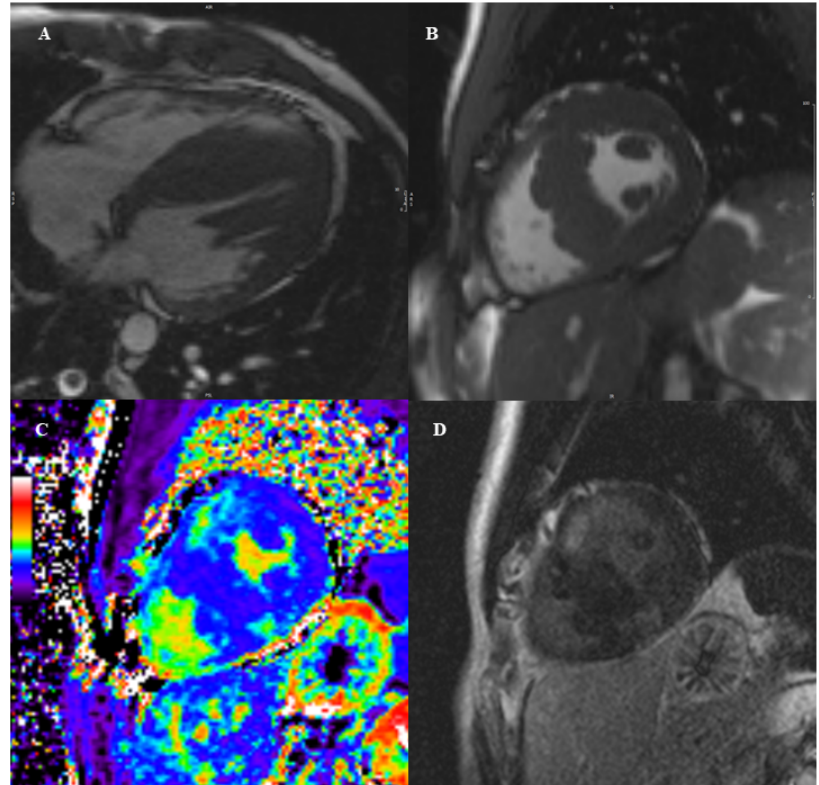
Figure 2. 13 year-old boy with positive family history for HCM. The CMR examination showed an asymmetric hypertrophy with prevalent involvement of the interventricular septum with a maximal wall thickness of 34 mm, and hypertrophy of papillary muscles (panel ( A , B )), which was highly suggestive for HCM. To implement diagnosis and risk stratification, we then performed tissue characterization sequences. We added parametric mapping sequences before and after contrast injection. As shown in panel ( C ), the calculated extracellular volume in the mid anterior and posterior septal wall was elevated (38%), as a sign of diffuse fibrosis. In the same segments late gadolinium enhancement was also evident with a patchy, intramyocardial distribution, as a sign of replacement fibrosis (panel ( D ).